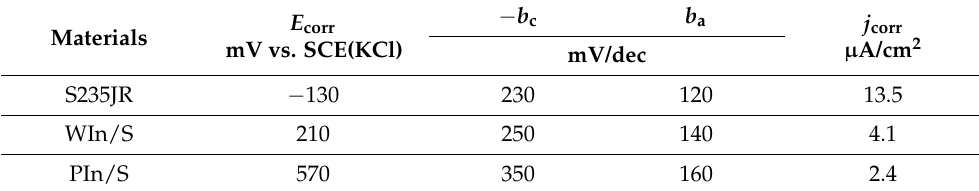
Table 5. Corrosion parameters of S235JR steel and Inconel 625